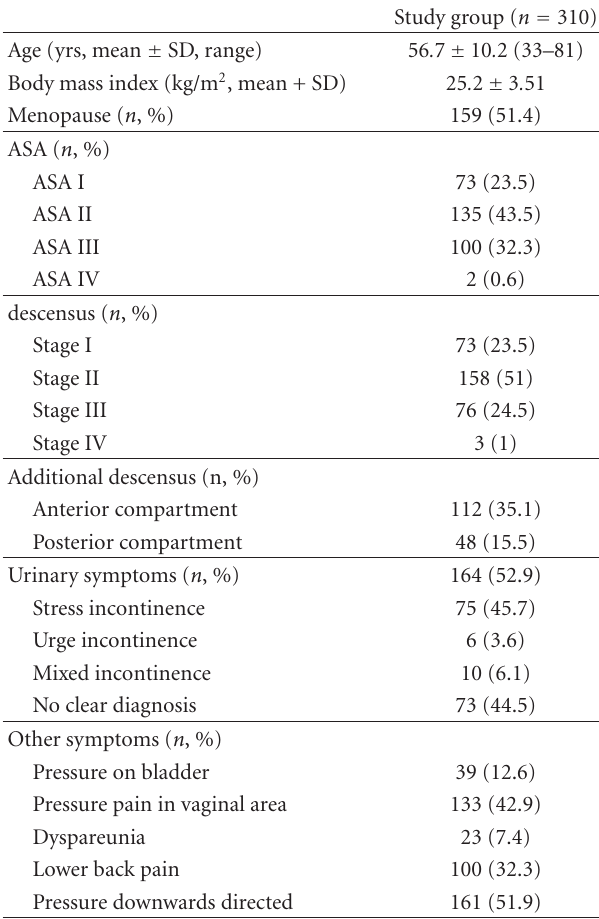
Table 1: Preoperative characteristics of the study